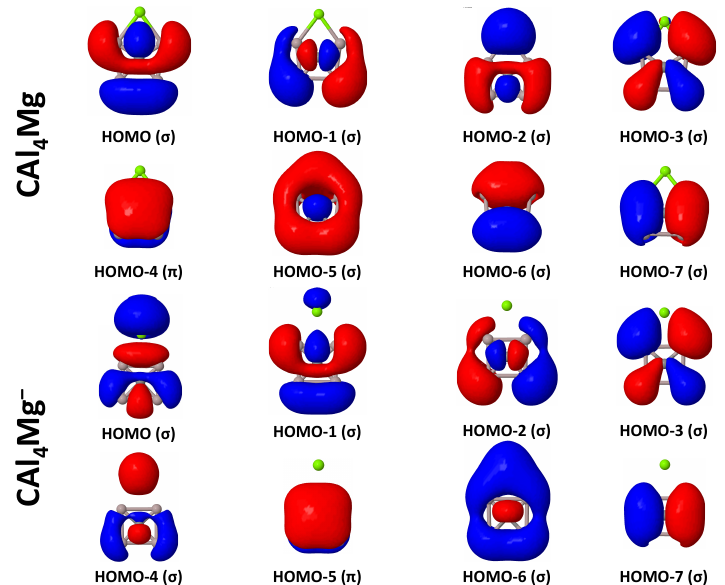
− ( 1a ) obtained at the 1n ) and CAl 4 Mg ( 4 Mg